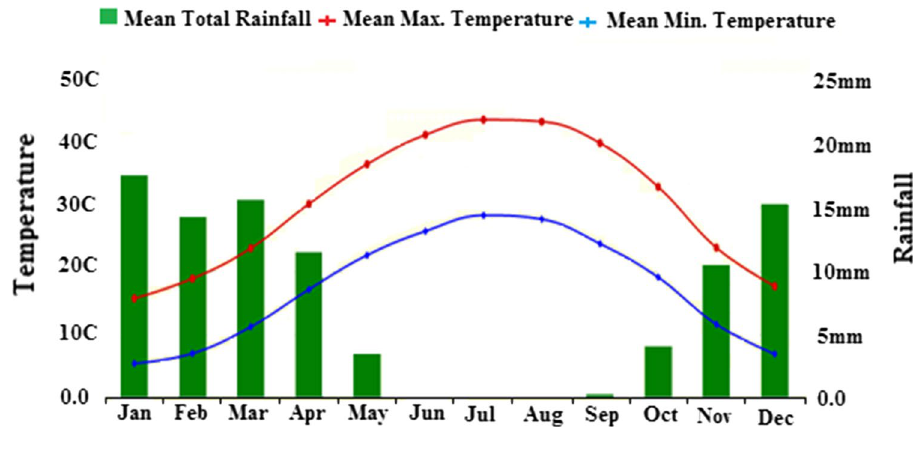
Table 1 Details of the suggested sewer line